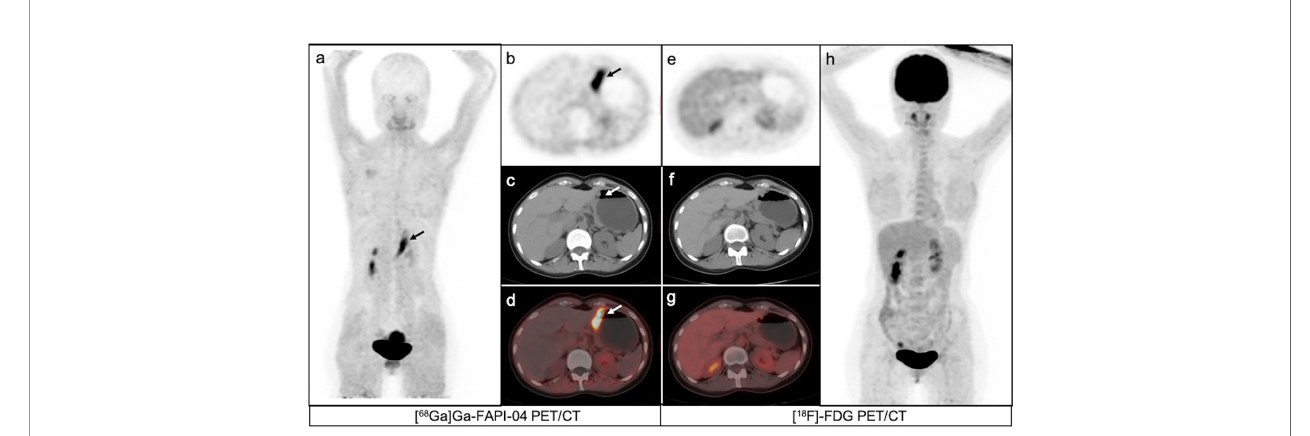
FIGURE 3 | A 35-year-old female patient with moderately differentiated gastric adenocarcinoma based on pathological biopsy under gastroscopy. [ 68 Ga]Ga-FAPI- 04PET/CT (A – D) revealed high uptake in the primary tumor (arrows, SUVmax=8.3) but negative uptake was observed on [ 18 F]-FDG PET/CT (E – H)